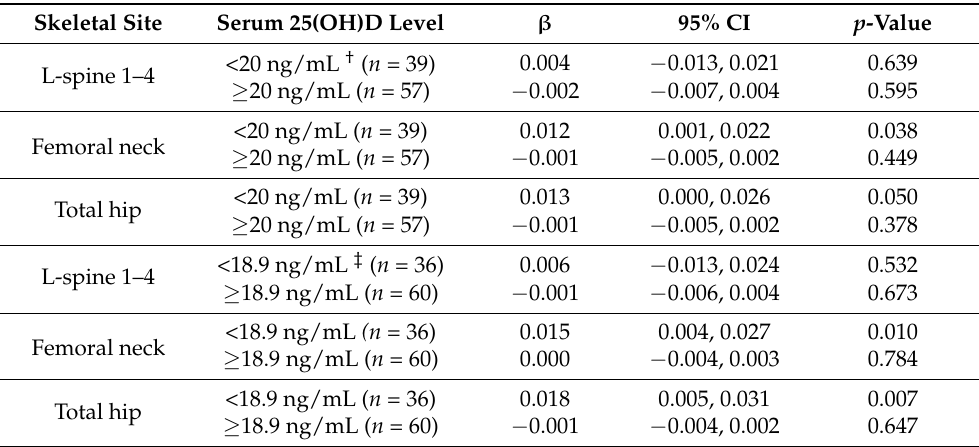
Table 4. Relationship between bone mineral density and the serum 25(OH)D levels.